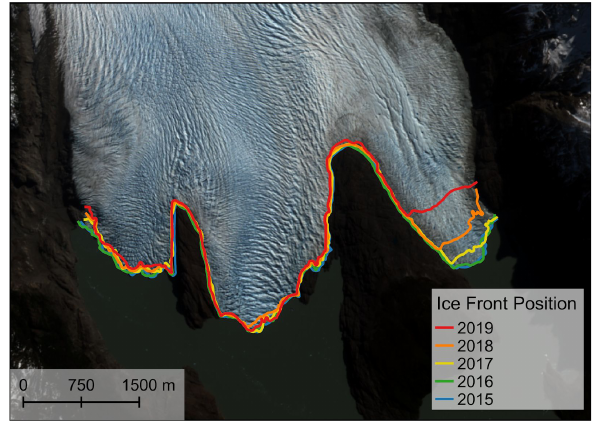
Figure 3. Grey Glacier’s ice front positions from 2015 to 2019.